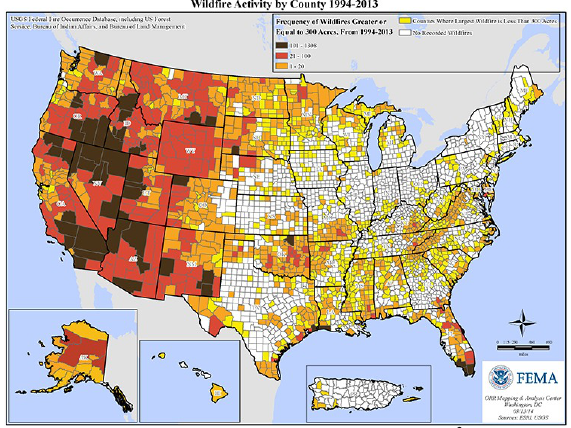
Figure 5. Wildfire activity by county 3